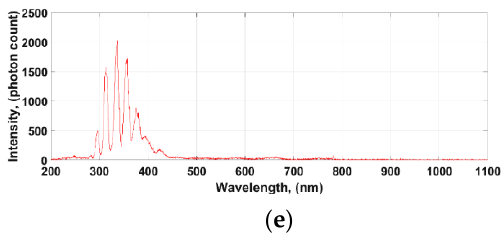
Figure 3. Examples of spectral characteristics for an electric arc generated in the air at a voltage of 4 kV AC with a frequency: 5 kHz (a); 30 kHz (b); 40 kHz (c); 100 kHz (d); 130 kHz (e).